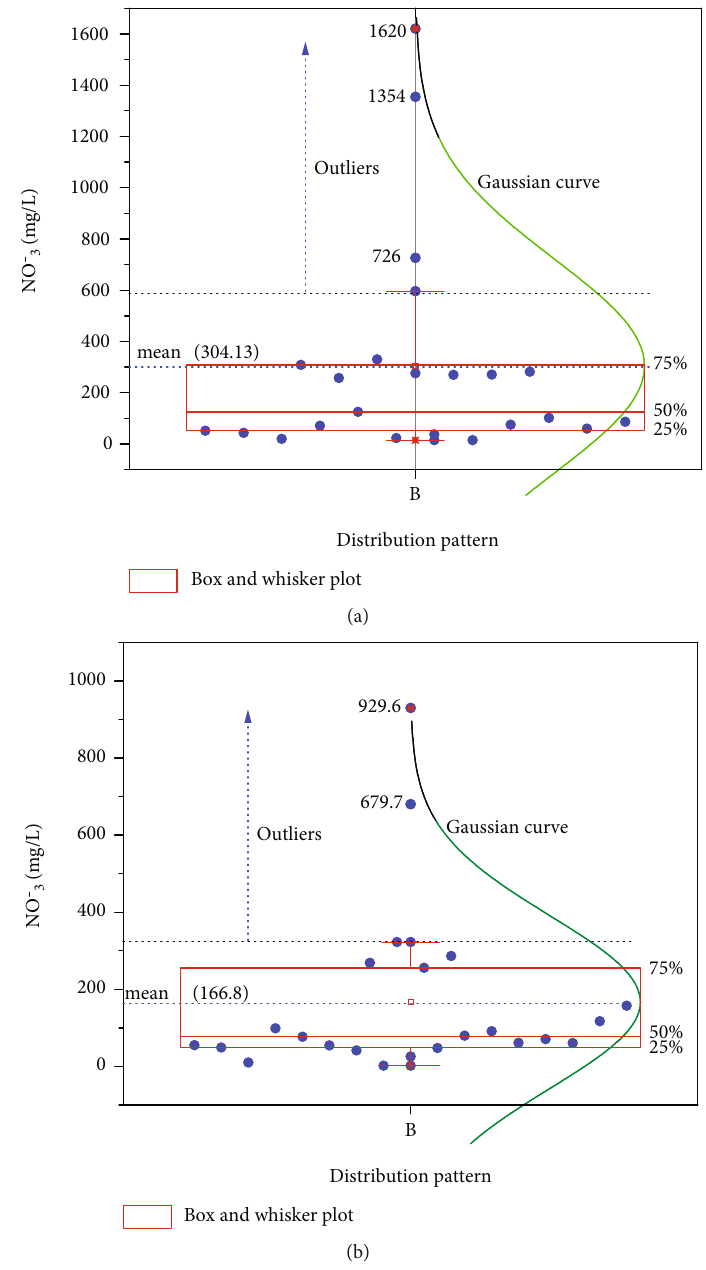
Figure 7: Outlier analysis showing nitrate distribution patterns in shallow wells during the (a) wet and (b) dry